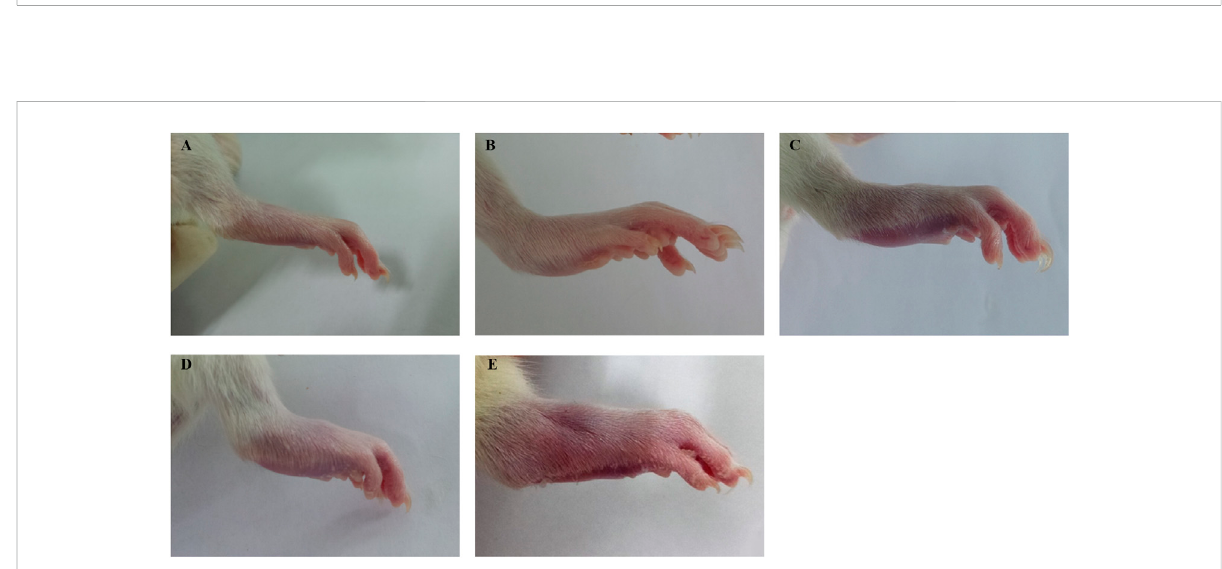
FIGURE 2 Example of arthritis index score in rats. (A) score 0. (B) score 1. (C) score 2. (D) score 3. (E) score